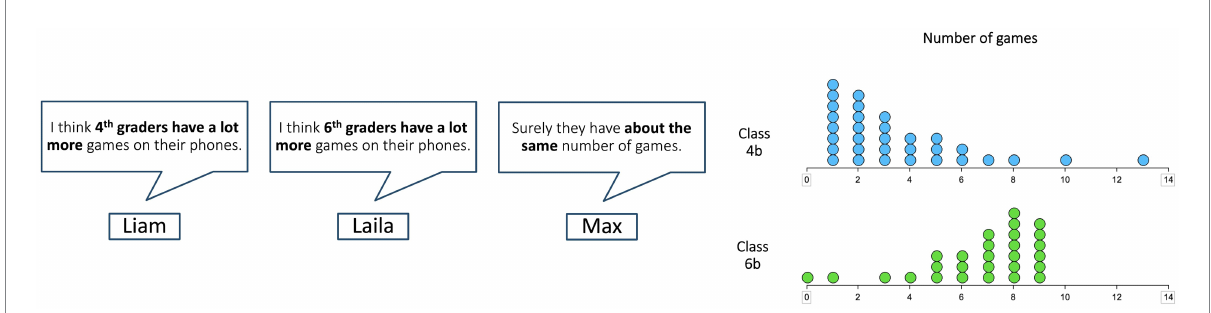
FIGURE 1 Sample item. Participants ( N = 25) were shown three assumptions of children (left) before and after they analyzed and compared the distributions (right). Eye-tracking data were collected only while the distributions were